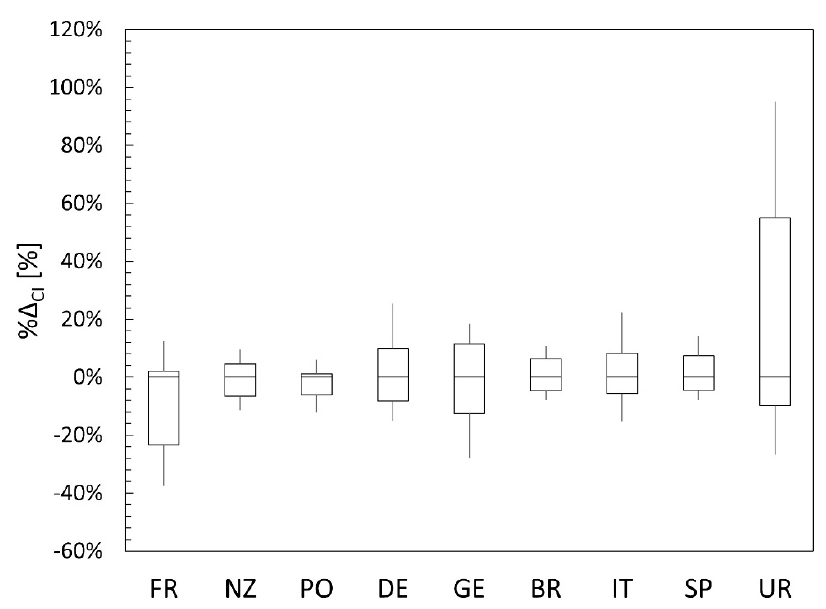
Figure 4. Relative variation of carbon intensity values compared to the median value for different countries (based on data from Tomorrow [45]).